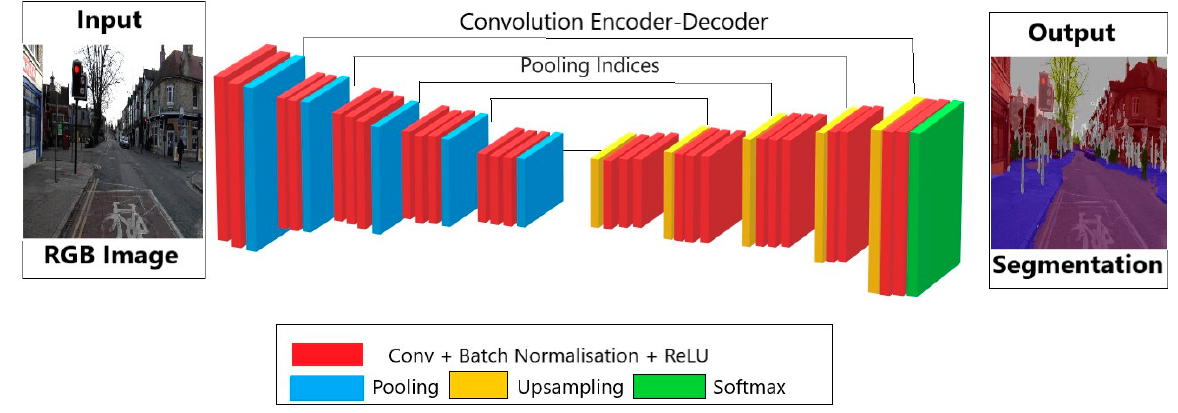
Figure 2. A CNN architecture for image segmentation.